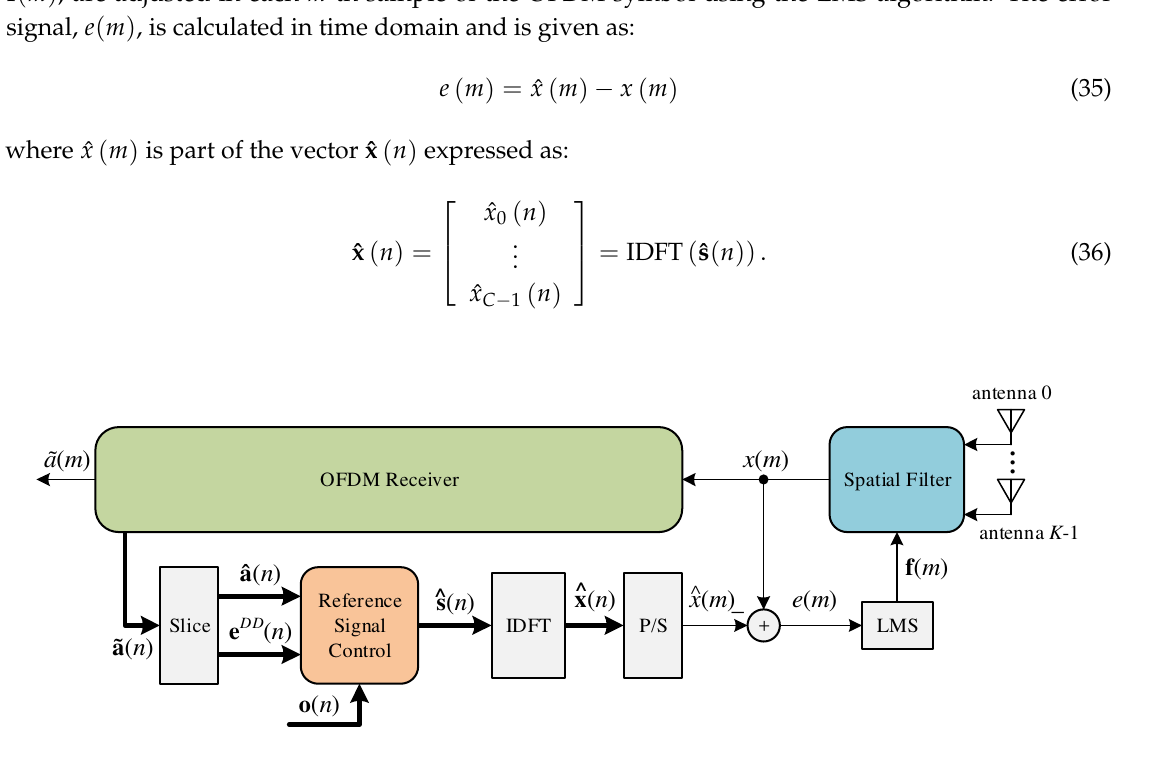
Figure 5. Adaptive antenna array proposed for the OFDM